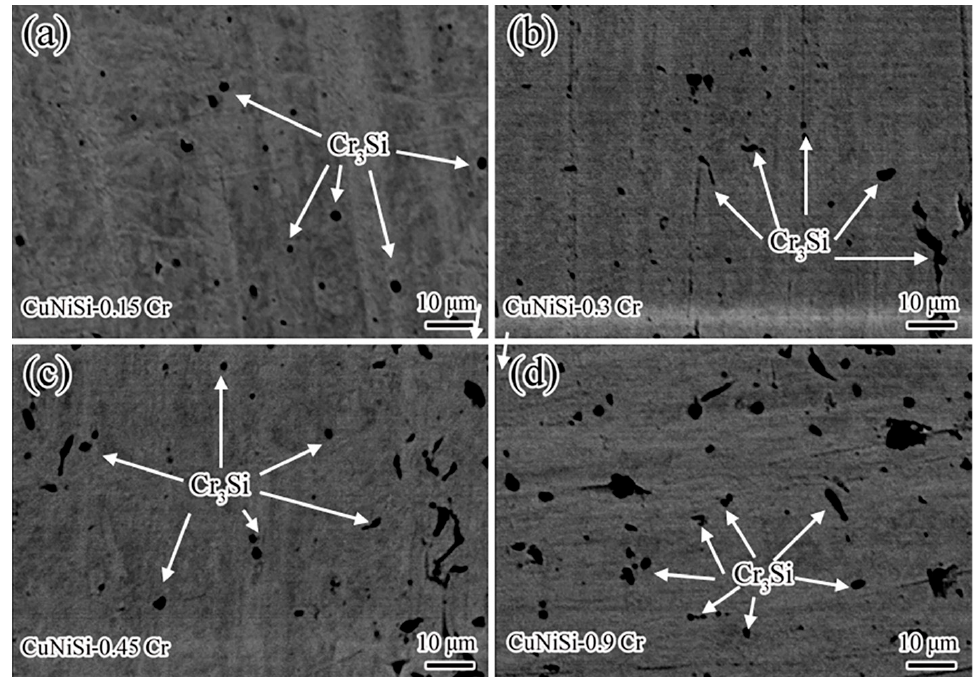
Figure 3. EMPA images of the CuNiSiCr alloys in solution treated state: ( a ) CuNiSi-0.15Cr, ( b ) CuNiSi-0.30Cr, ( c ) CuNiSi-0.45Cr and ( d ) CuNiSi-0.90Cr. Table 2. EPMA results on the matrix of the CuNiSiCr alloys (in wt.%). Alloys Ni Si Cr CuNiSi-0.15Cr 2.24 ± 0.06 0.50 ± 0.04 0.14 ± 0.02 CuNiSi-0.30Cr 2.33 ± 0.05 0.47 ± 0.01 0.20 ± 0.03 CuNiSi-0.45Cr 2.36 ± 0.06 0.44 ± 0.02 0.23 ± 0.01 CuNiSi-0.90Cr 2.34 ± 0.06 0.37 ± 0.02 0.26 ±